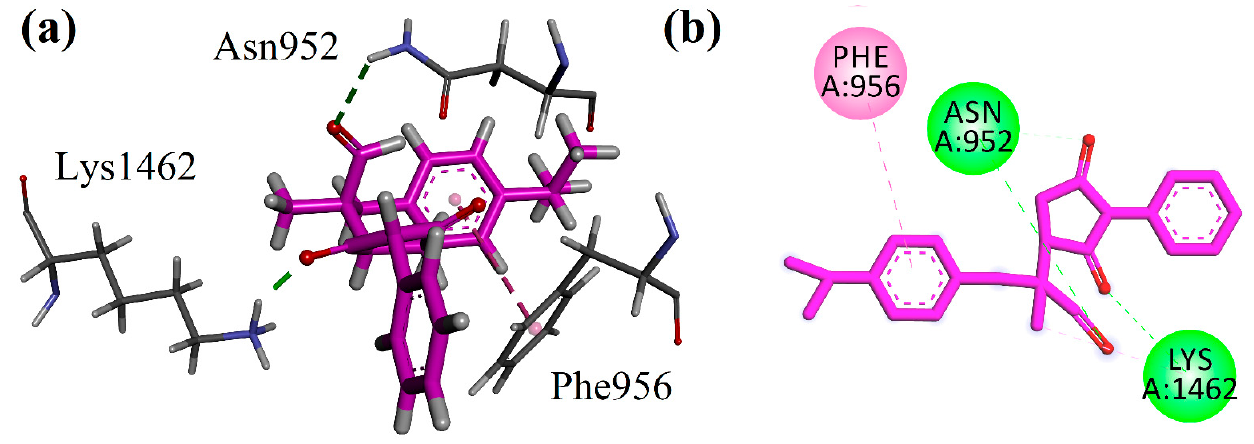
Figure 5. The 3-D/2/D interaction plot of R,S-1 in the binding site of 6KZP.